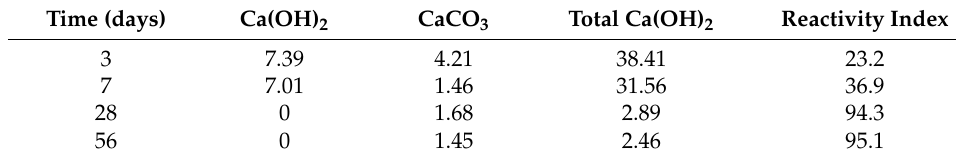
Table 6. Pozzolanic activity results: Reprinted with permission from [44].